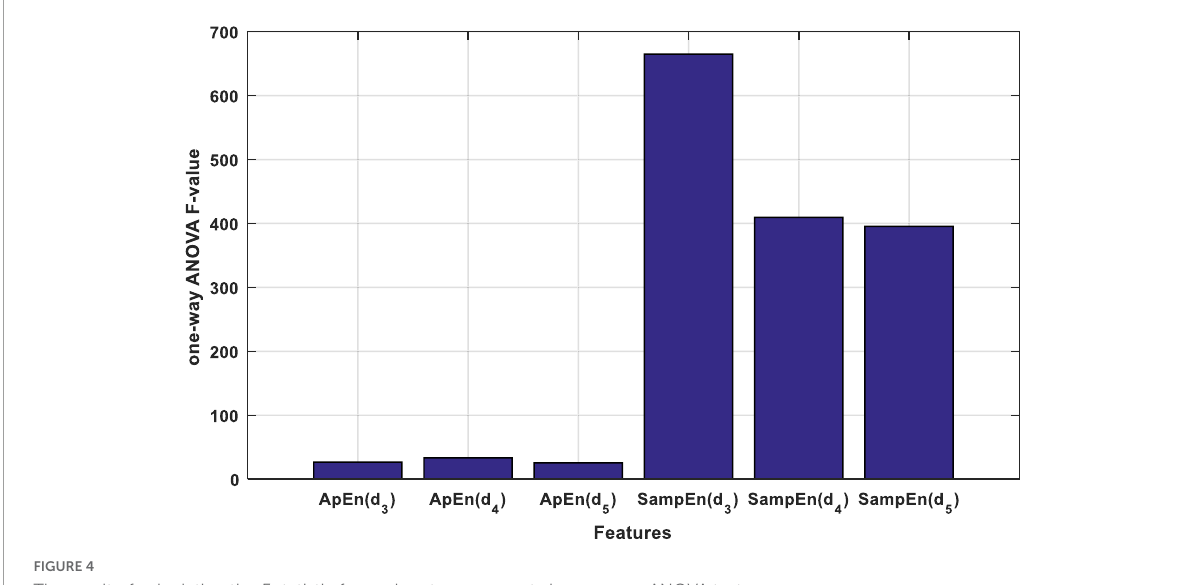
FIGURE4 The result of calculating the F statistic for each entropy property by one-way ANOVA test.